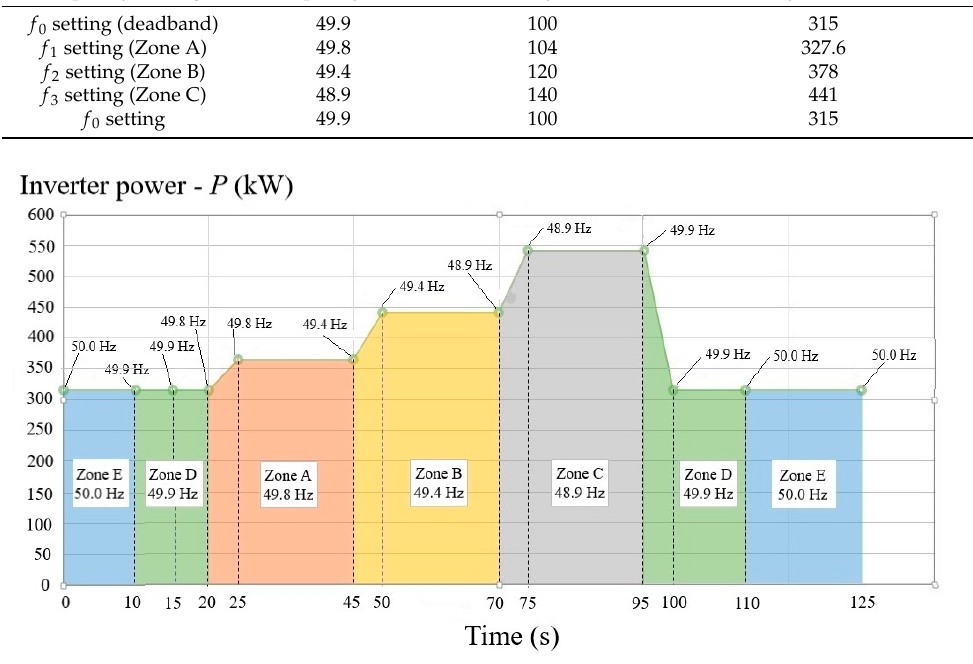
Figure 3. Diagram of increase in PVP power under frequency